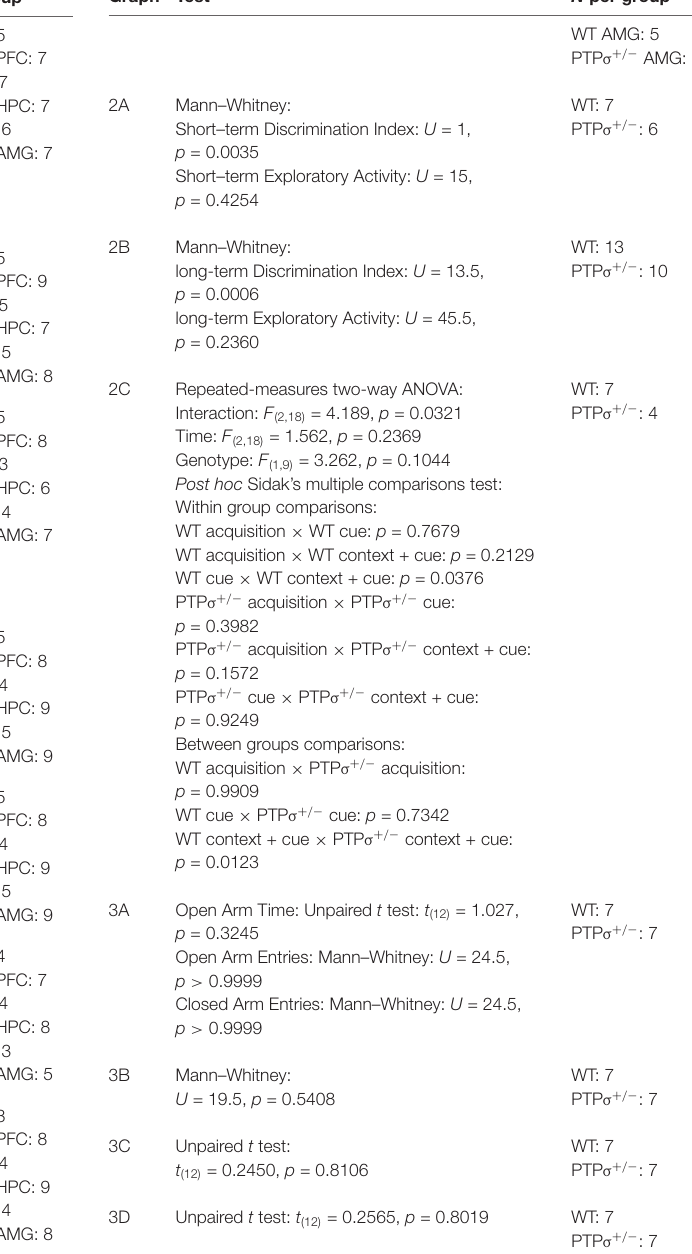
TABLE 1 | Statistical analysis of the experimental data. Graph Test N per